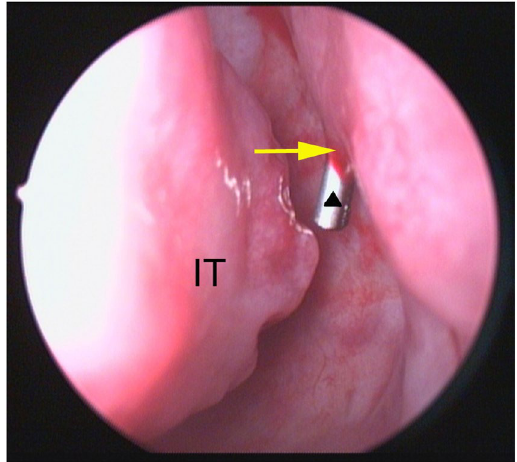
Figure 4. Under nasal endoscope, the wire-threaded hollow probe (black triangle) could be seen enter the inferior meatus through the opening of the nasolacrimal duct (yellow arrow). IT, inferior turbinate.